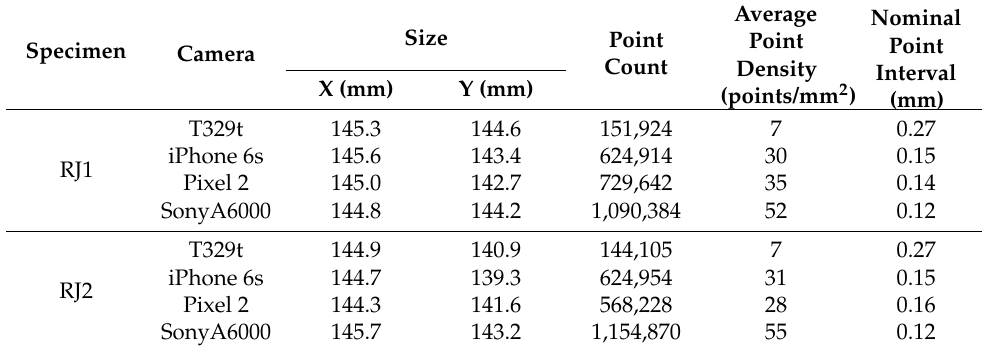
Table 5. The average point density and nominal point interval of the SfM models under the moving smartphone capture (MSC) mode.